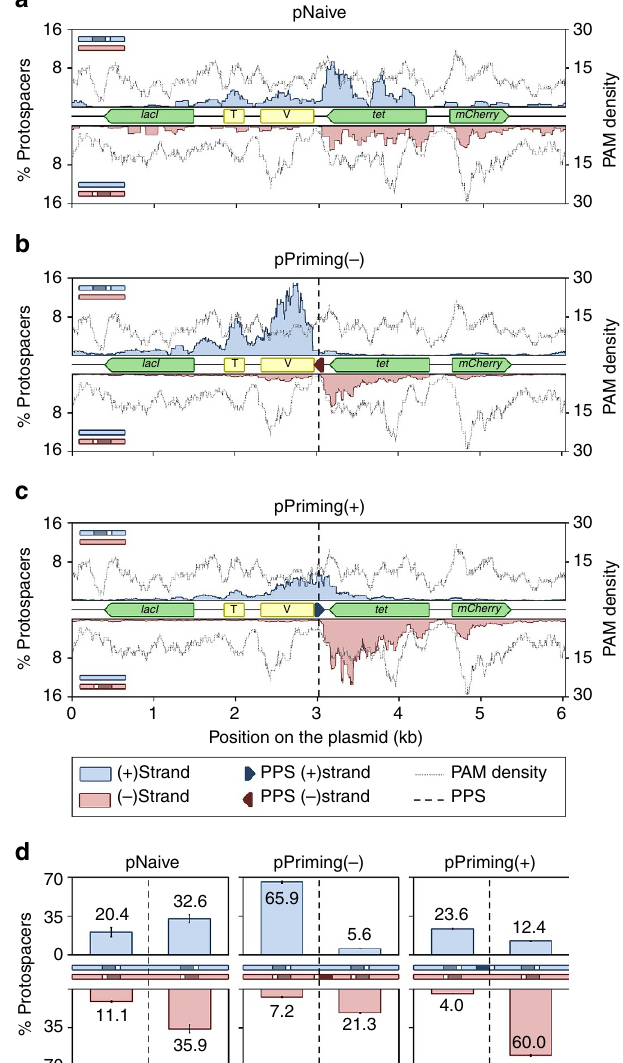
Figure 5 | Protospacer mapping of the first acquired spacer in CRISPR1. The protospacer locations of the first acquired spacer in CRISPR1 (that is, the most leader-distal, new spacer) were mapped on ( a ) pNaive, ( b ) pPriming( (cid:2) ) or ( c ) pPriming( þ ) using a sliding 150nt binning window. ( d ) Proportion of newly targeted protospacers 5 0 and 3 0 of the PPS on each strand. Labelling is the same as Fig. 4. Error bars represent the s.e. of the